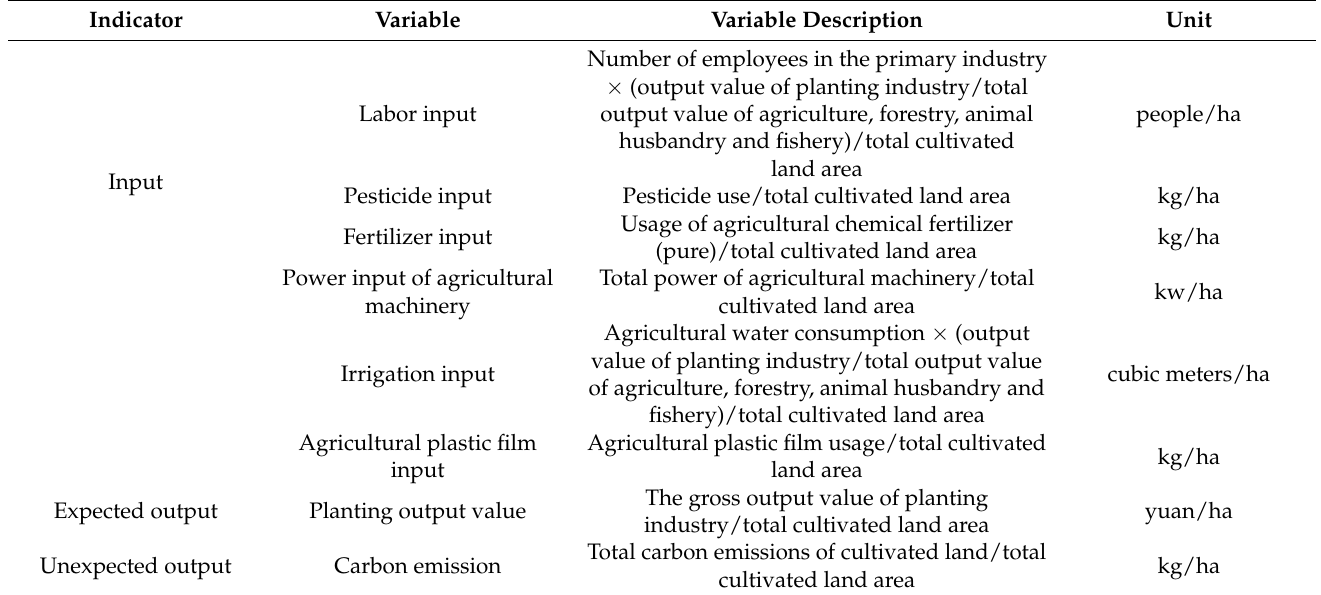
Table 1. Index system of the cultivated land use efficiency evaluation.